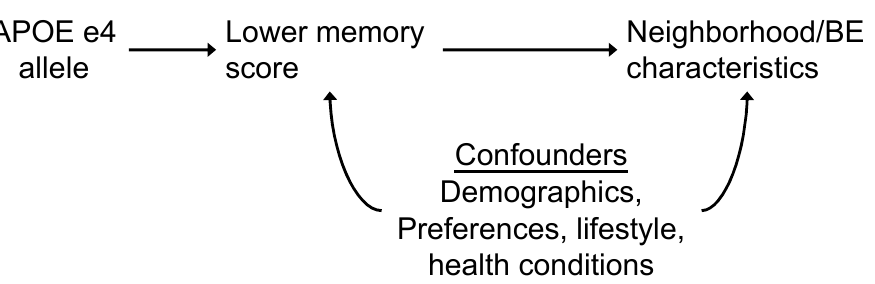
Figure 2. APOE genotype as instrumental variable to study potential reverse causality of association between neighborhood NDVI and episodic memory. If APOE is associated with NE/BE characteristics, it is likely through cognition and provides support for reverse causality.